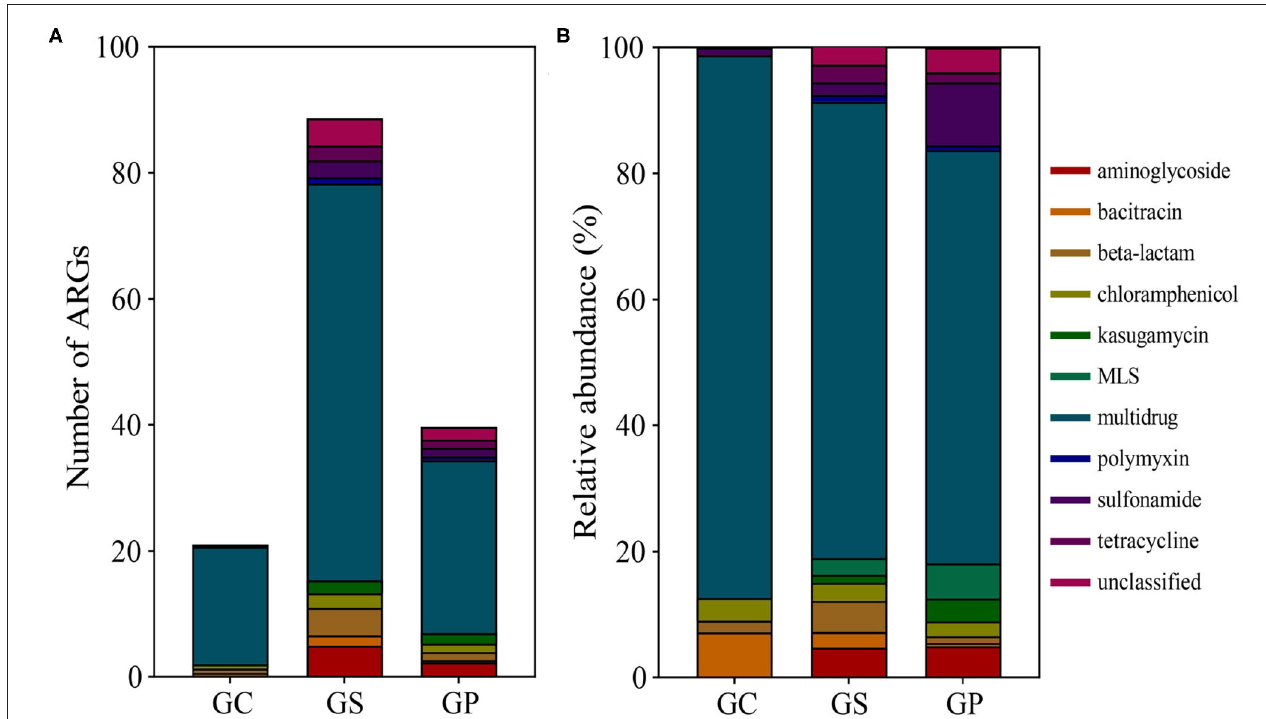
FIGURE 1 | ARGs detected during GP processing. (A) The number of resistance genes detected during GP processing. (B) The relative abundance of ARGs in the three products.